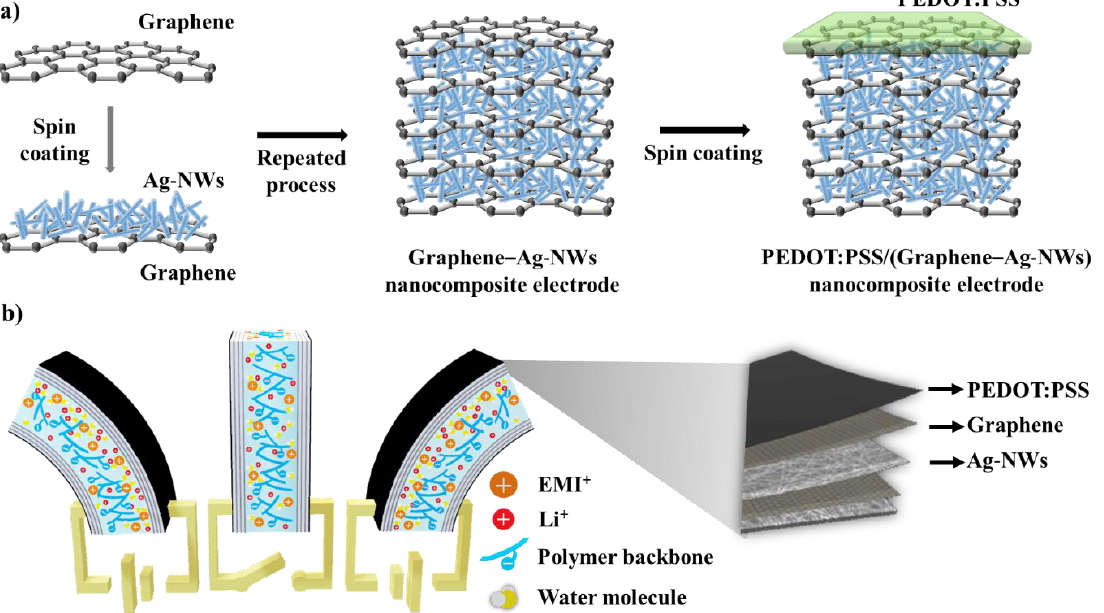
Figure 1. Schematic diagrams of IEAP actor based on PEDOT:PSS/(graphene–Ag-NWs) nanocomposite electrodes: ( a ) synthesis of a PEDOT:PSS/(graphene–Ag-NWs) nanocomposite electrode; ( b ) design of IEAP actuator based on PEDOT:PSS/(graphene–Ag-NWs) nanocomposite electrodes.